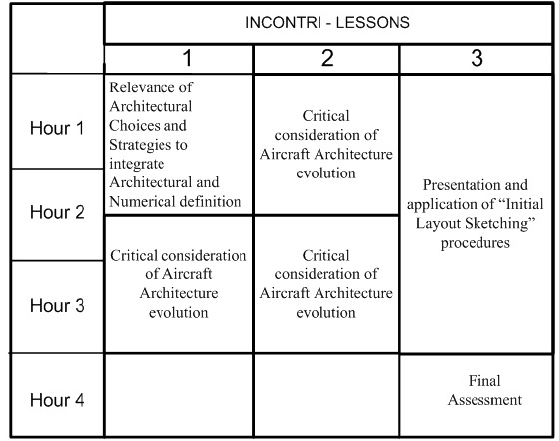
Fig. 5. Course organization